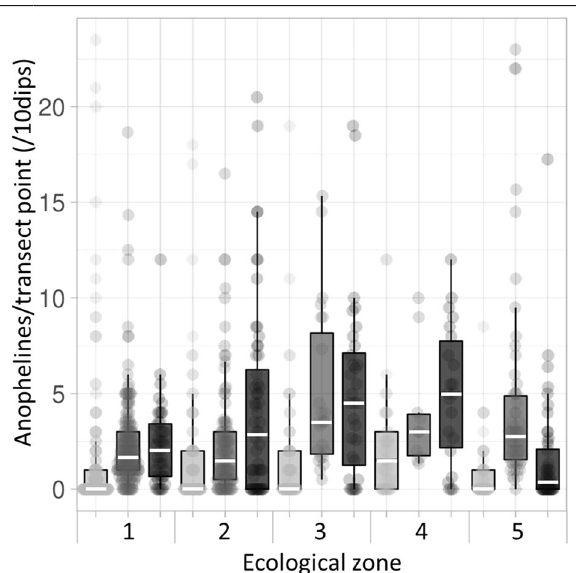
Figure 8. Distribution of Anopheles larvae across ecological zones in western Zambia. Sampling undertaken in the dry season of 2017 (light grey) and after peak of the wet season in 2018 (mid grey) and 2019 (dark grey). Total anopheline larvae per transect point (standardised per ten dips) represented by dots; boxplot indicates interquartile range and median (white horizontal line), with whiskers extending to minimum and maximum values within 1.5 times IQR. 2017: n = 407 transect points; 2018: n = 340; 2019: n = 220. Ecological zones as per Fig.